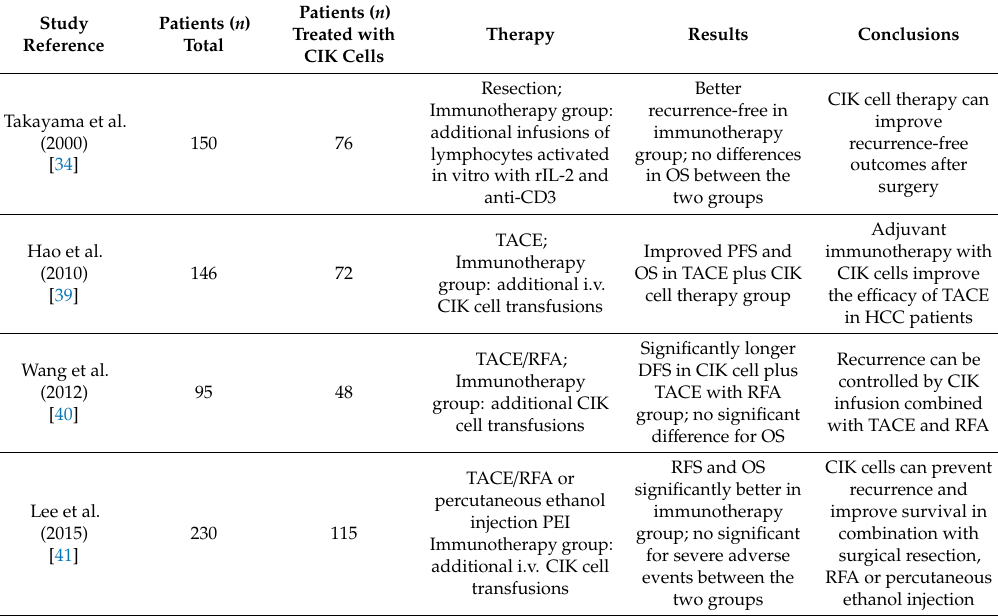
Table 1. Clinical studies applying CIK cells for the treatment of